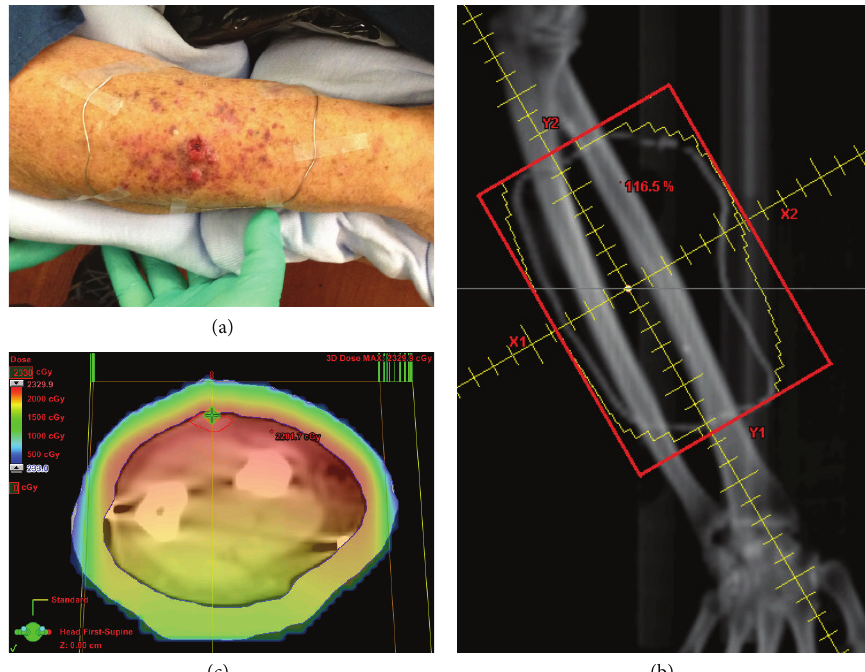
Figure 1: Secondary cutaneous plasmacytoma presenting as (a) nodularity on patchy violaceous background at dorsal surface of patient’s right forearm. (b) Right forearm AP treatment field, as outlined in red, with (c) dosimetry shown on axial planning computed tomography